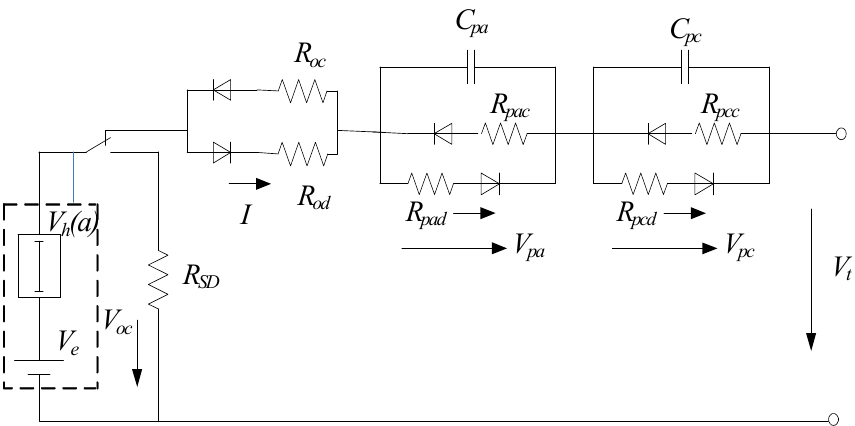
Figure 2. Proposed equivalent circuit model for the lithium-ion